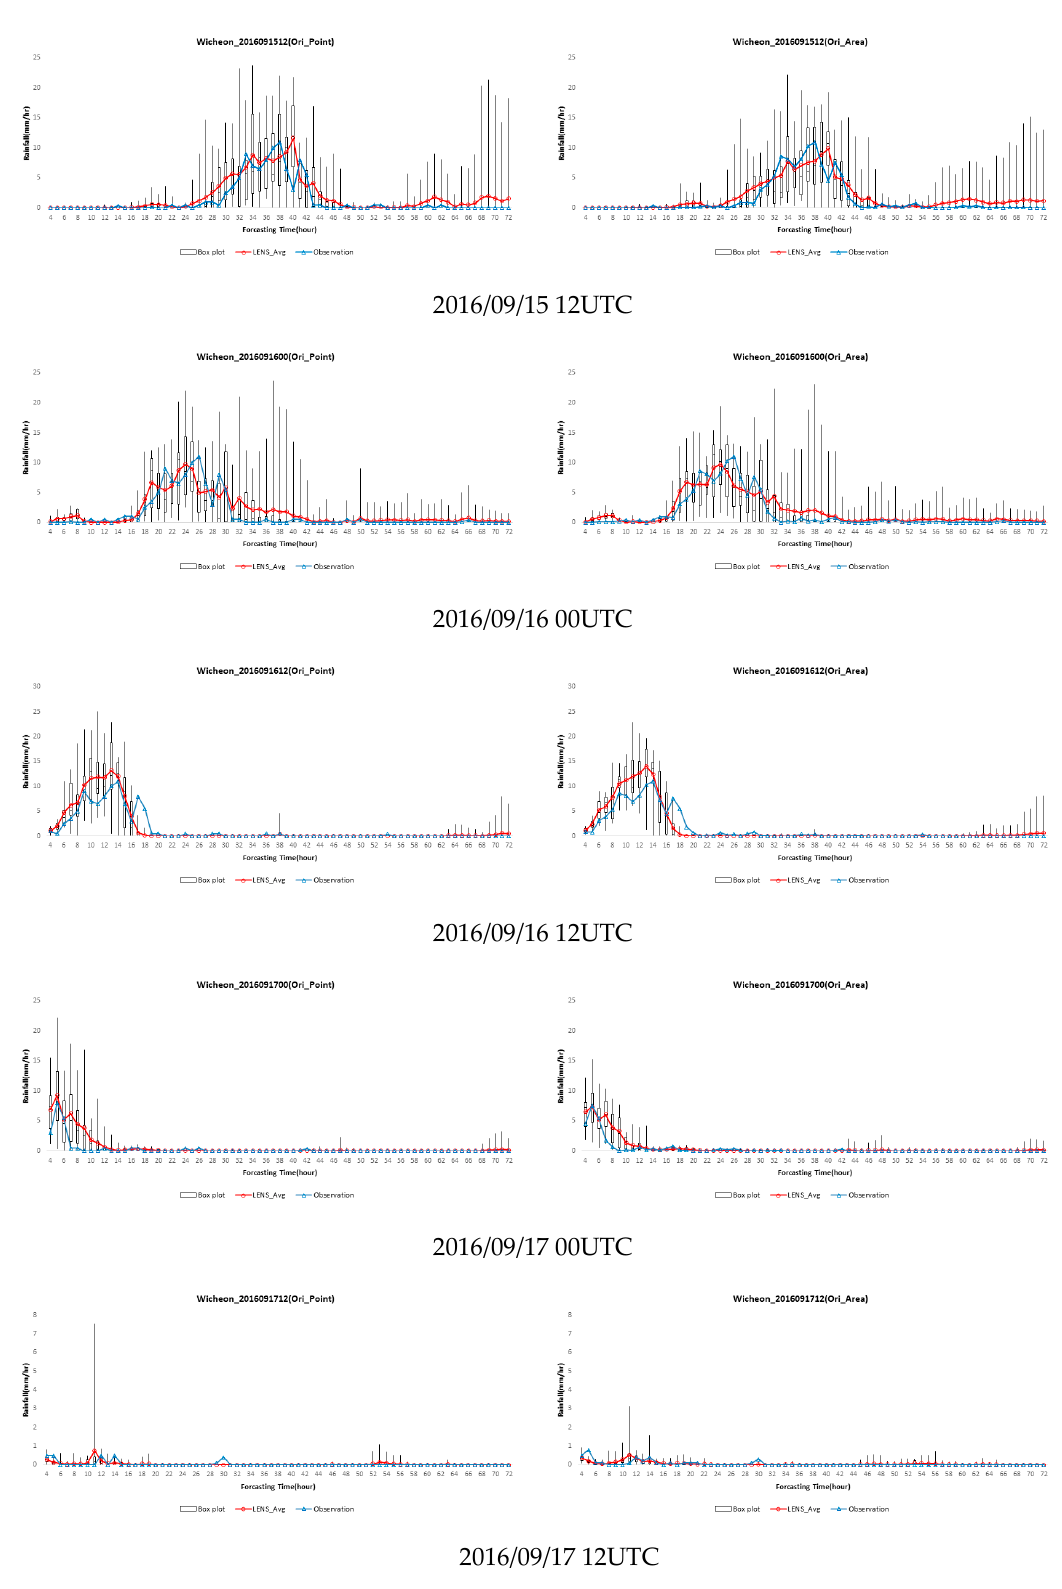
Figure 7. LENS-observation forecasting time-value graph (Wicheon, event W) .